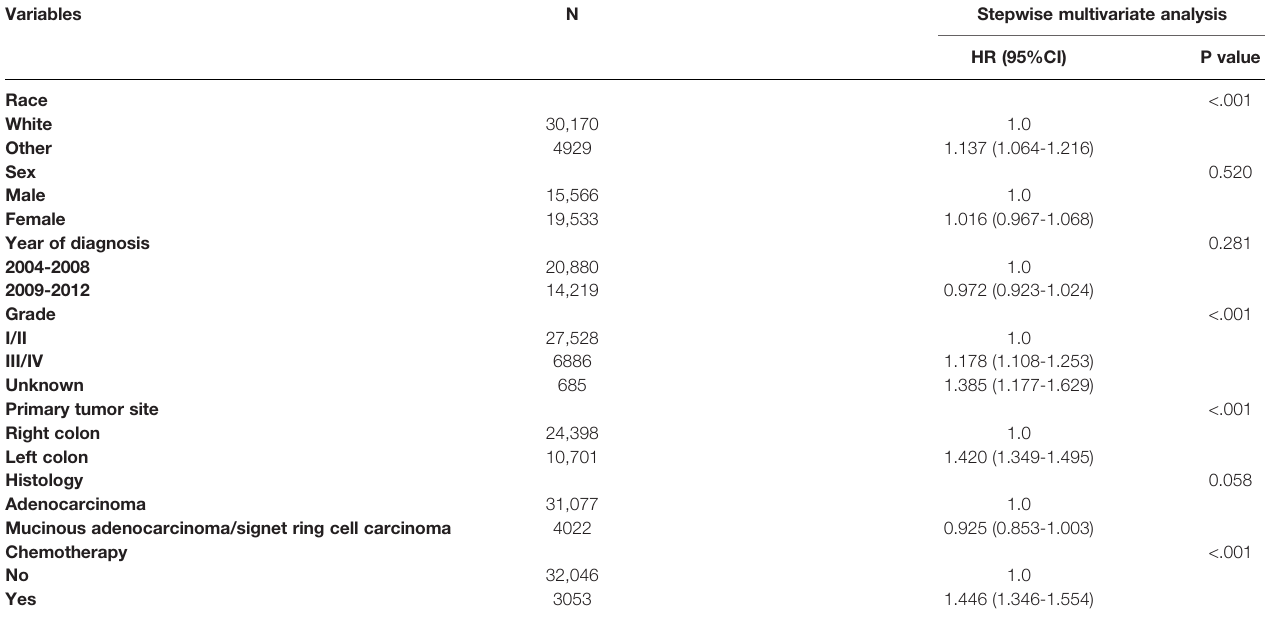
TABLE 3 | Multivariate Cox regression analyses for survival in stage II colon cancer.